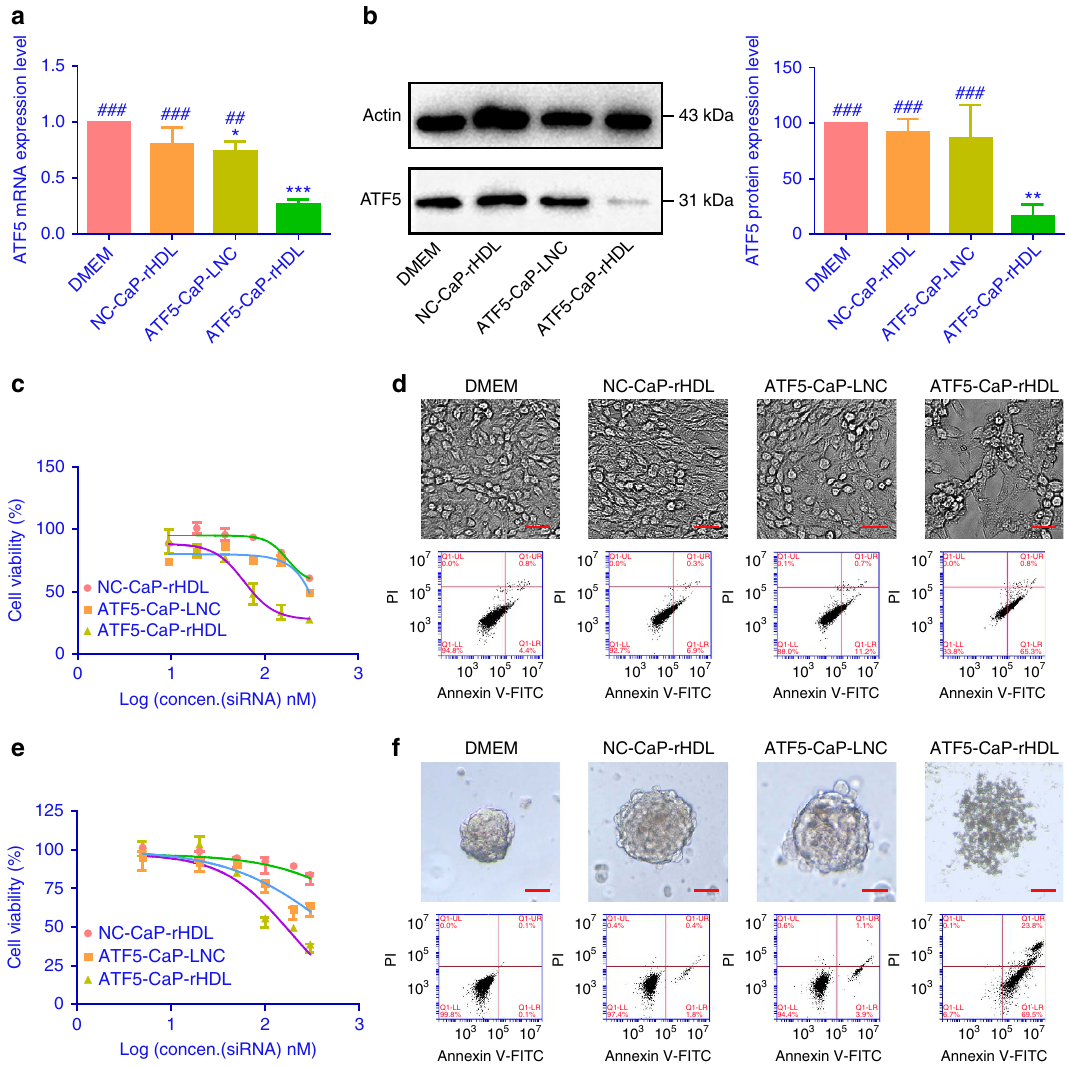
Figure 8 | In vitro anti-glioblastoma activity of ATF5-CaP-rHDL. ( a ) The mRNA level of ATF5 in C6 glioblastoma cells after the treatment with NC-CaP- rHDL, ATF5-CaP-LNC or ATF5-CaP-rHDL for 48h. ( b ) The protein level of ATF5 in C6 glioblastoma cells after the treatment with NC-CaP-rHDL, ATF5- CaP-LNC or ATF5-CaP-rHDL for 48h. For a and b , data represent mean ± s.d. ( n ¼ 3). The significance of the differences was evaluated by one-way ANOVA followed by Bonferroni test. * P o 0.05, ** P o 0.01, *** P o 0.001 significantly different with that of the DMEM, ## P o 0.01, ### P o 0.001 significantly different with that of the ATF5-CaP-rHDL. ( c ) Cell viability of C6 glioblastoma cells after the treatment with NC-CaP-rHDL, ATF5-CaP-LNC or ATF5-CaP- rHDL for 48h. ( d ) Induction of apoptosis in C6 glioblastoma cells following 48h incubation with various siRNA formulations at the siRNA concentrations 100nM. The upper four images are bright field images of C6 glioblastoma cells. Scale bar, 50 m m. The bottom four images are flow cytometry results. ( e ) Cell viability of GICs after the treatment with NC-CaP-rHDL, ATF5-CaP-LNC or ATF5-CaP-rHDL for 48h. ( f ) Induction of apoptosis in GICs following 48h incubation with NC-CaP-rHDL, ATF5-CaP-LNC or ATF5-CaP-rHDL at the siRNA concentration 200nM. The upper four images are bright field images of GICs. Scale bar, 50 m m. The bottom four images are flow cytometry U251, pancreatic cancer cells MIA PaCa-2 and colorectal cell lines SW-480 cells, and the efficiency of these cellular uptakes of CaP-rHDL is linear dependent on the Ras-GTP activation